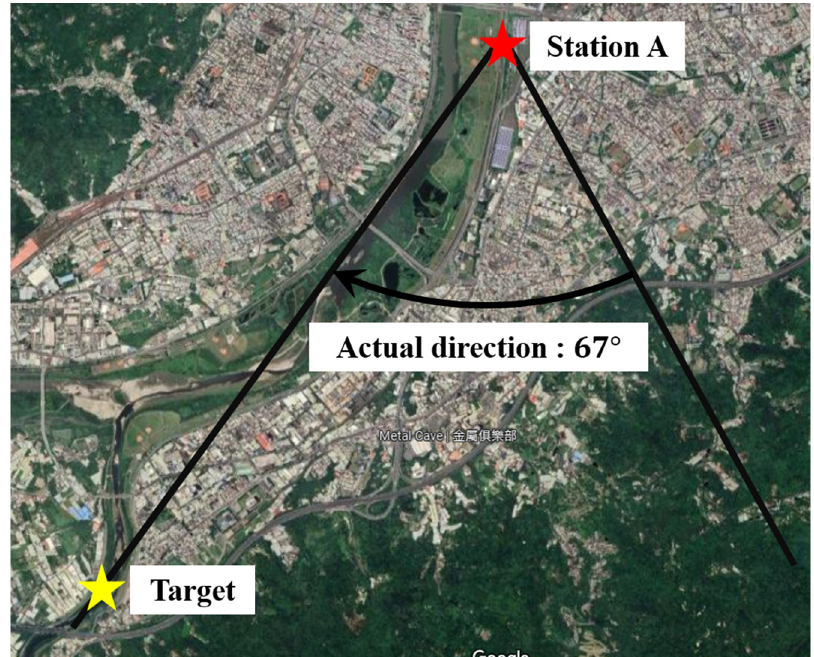
Figure 12. Single station measurement setup.